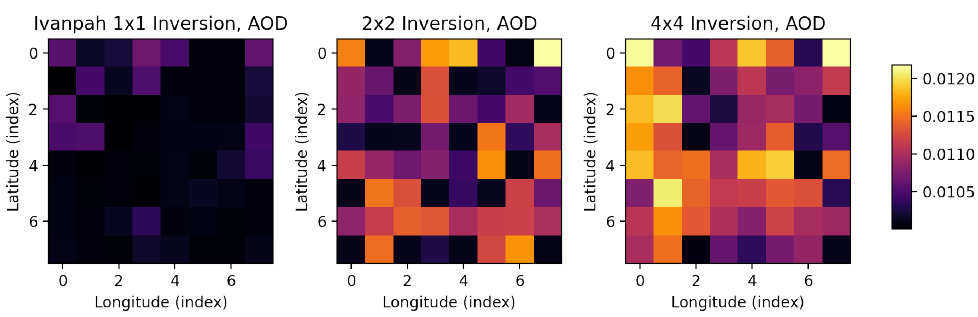
Figure 7. The aerosol optical depth prediction for validation data at Ivanpah. The predictions are effectively identical, but the spatial retrievals are closer to the in situ measurement of